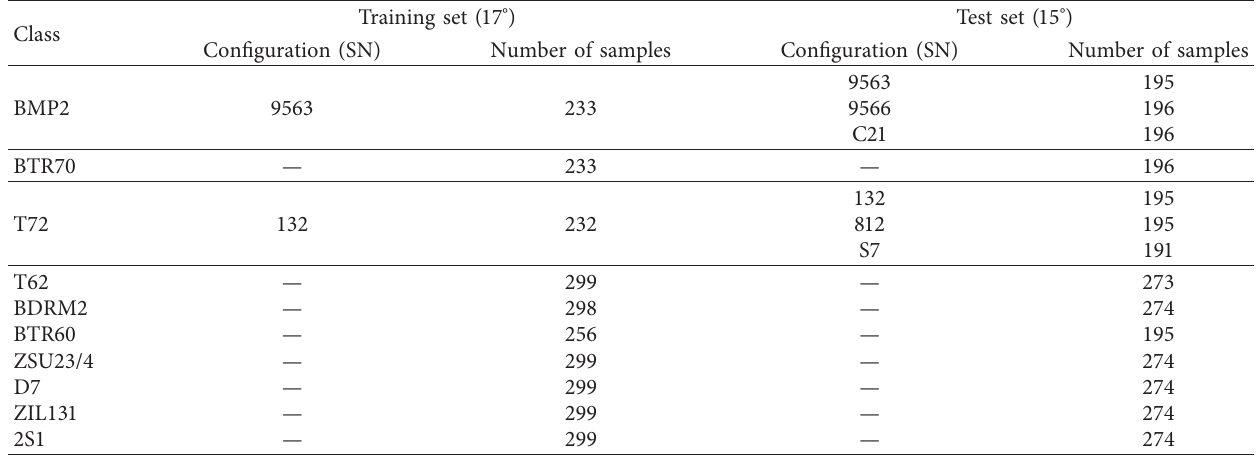
Table 1: Training and test samples under SOC.